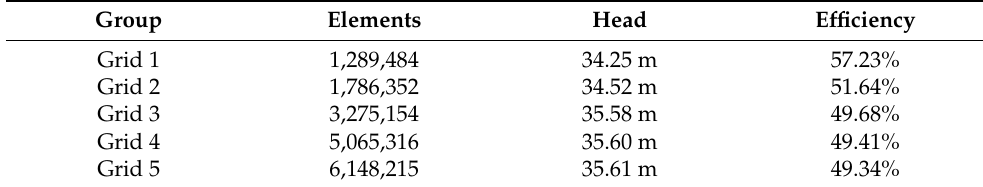
Figure 2. The grid of computational domain for pump: ( a ) Whole computational domain; ( b ) Grid for impeller. Table 1. Geometrical parameters of the 10-stage model pump.